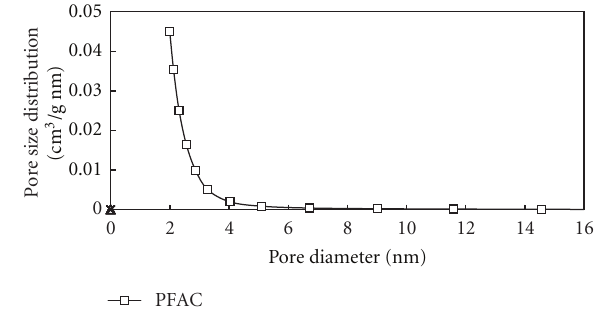
F 2: Pore size distribution of PFAC.